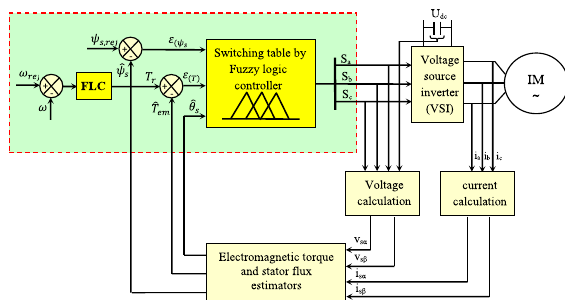
Fig. 6 Synoptic schema of DTC-Fuzzy control of the induction machine